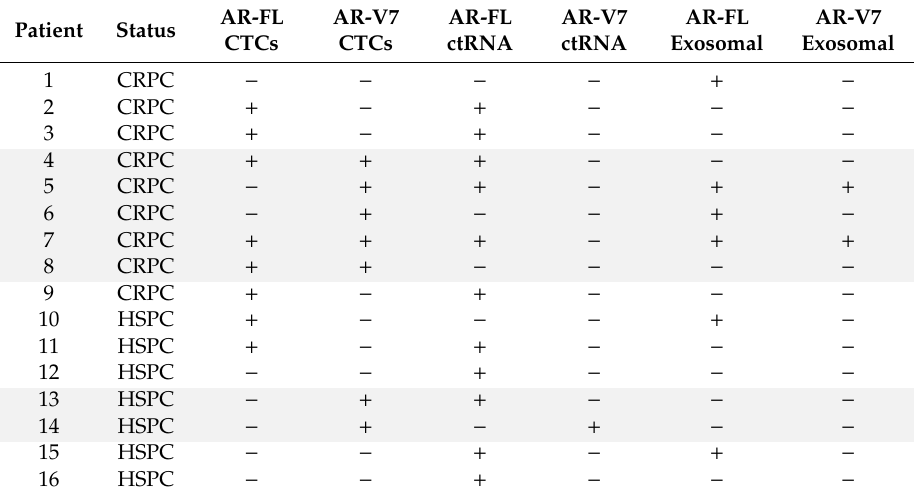
Figure 3. Detection of AR-FL (left) and AR-V7 (right) transcripts. Comparison of AR-FL and AR-V7 detection in CTC RNA and ctRNA from the same blood draw illustrated by mirrored scatter blot for the 44 patient samples (sorted in relation to detection in CTCs); summarized data are tabled below. *, ** indicate significance p -value ≤ 0.5 and ≤ 0.01, respectively. Table 3. AR-FL/AR-V7 status in 16 patients tested from CTC, ctRNA and exosomal samples.